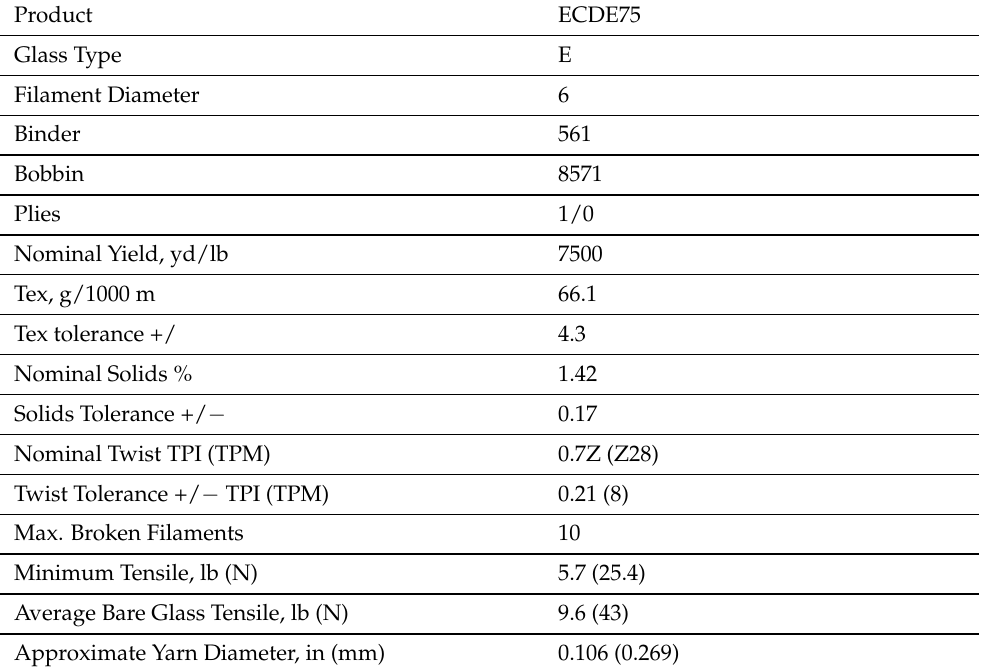
Table 3. E-glass fiber-sized yarns specs